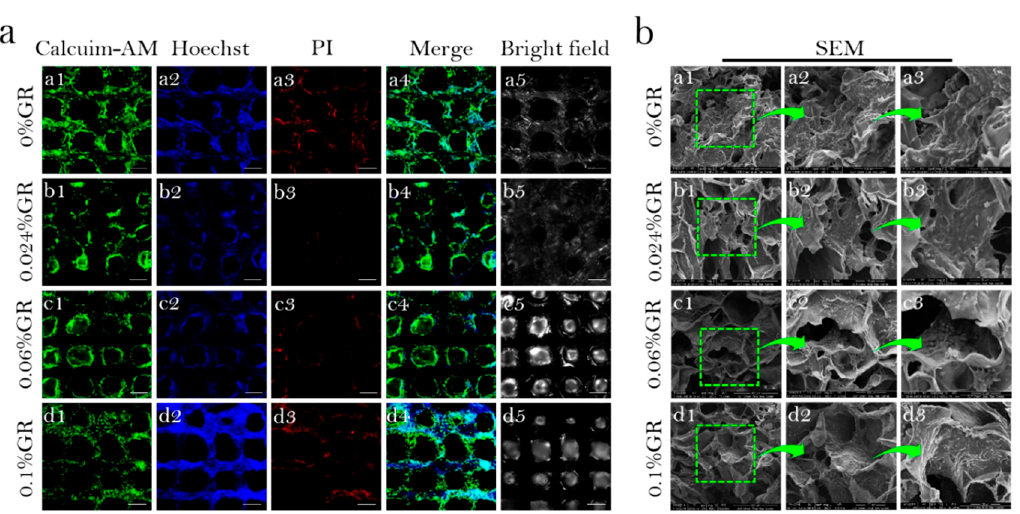
Figure 7. Biological activity of bio-scaffolds. ( a ): Viability and distribution of BMSCs on CS/Gel/HA/GR scaffolds. (a 1 –a 5 ) 0% GR scaffold, (b 1 –b 5 ) 0.024% GR scaffold, (c 1 –c 5 ) 0.06% GR scaffold, (d 1 –d 5 ) 0.1% GR scaffold, (a 1 –d 1 ): Calcuim-AM stain of CS/Gel/HA/GR scaffolds, (a 2 –d 2 ): Hoechst stain of CS/Gel/HA/GR scaffolds, (a 3 –d 3 ): PI stain of CS/Gel/HA/GR scaffolds, (a 4 –d 4 ): Merge stain of CS/Gel/HA/GR scaffolds, (a 5 –d 5 ): Bright field of CS/Gel/HA/GR scaffolds, (Scale: 50 μ m); ( b ): SEM of bioscaffold-cell composite. (a 1 –a 3 ) 0% GR scaffold, (b 1 –b 3 ) 0.024%GR scaffold, (c 1 –c 3 ) 0.06% GR scaffold, (d 1 –d 3 ) 0.1% GR scaffold, (a 1 –d 1 ) 400×, (a 2 –d 2 ) 800×, (a 3 –d 3 ) 1600×.